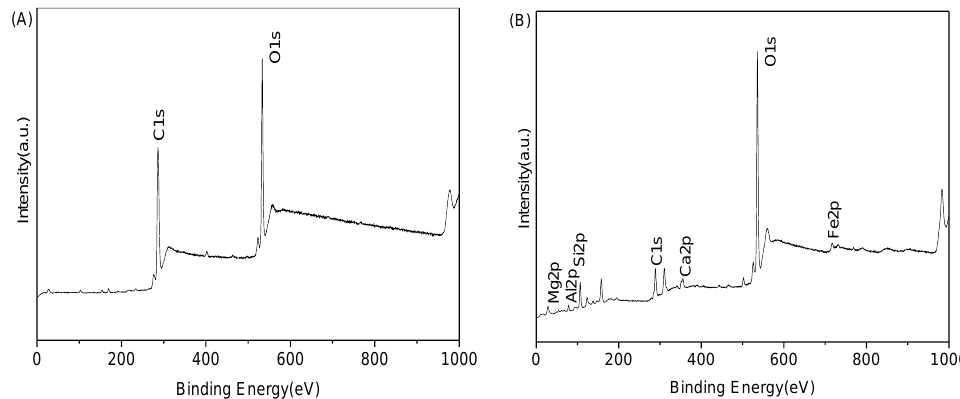
Figure 4. X-ray photoelectron spectroscopy (XPS) spectra of ( A ) GO and ( B ) as-prepared GO.